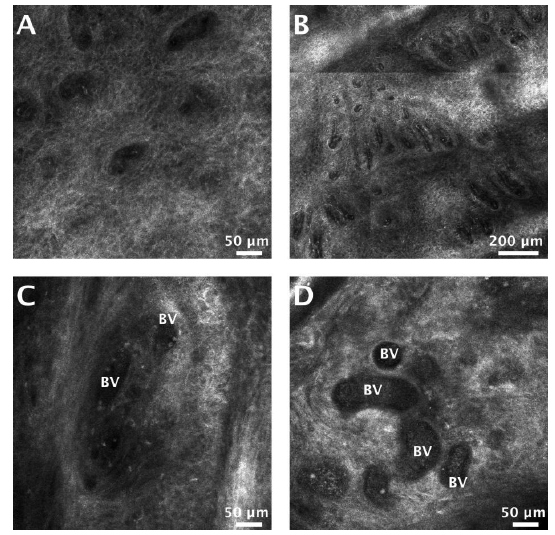
Figure 3. Blood vessel density and blood vessel dilation in actinic cheilitis (AC) and lip squamous cell carcinoma (SCC). ( A ) Reflectance confocal microscopy (RCM) image showing blood vessels (dark areas in the honeycomb) at the level of the dermal-epidermal junction (DEJ), in an AC lesion. ( B ) RCM mosaic (1305 × 1305 µ m) displaying a high density of blood vessels at the DEJ in a SCC. ( C ) RCM image of dilated blood vessels (BV) filled with moderately-refractile particles (corresponding to blood cells) in an AC lesion. ( D ) RCM image showing markedly dilated blood vessels (BV) at dermal level in a